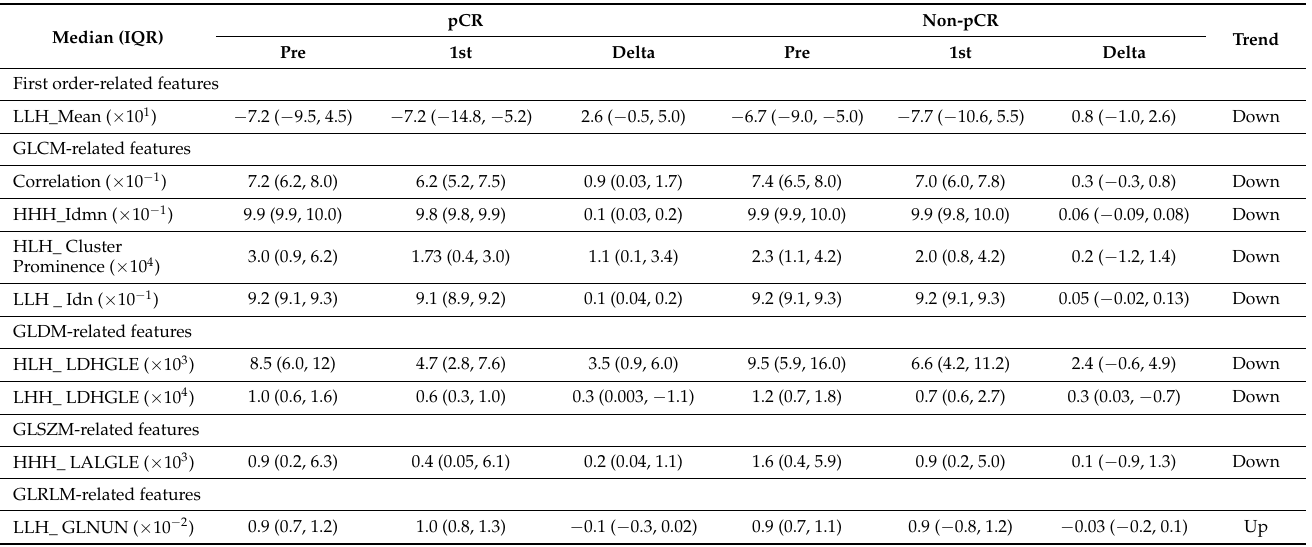
Table 4. The nine key radiomic features in the delta-radiomics model and their pre-radiomics and 1st-radiomics features.